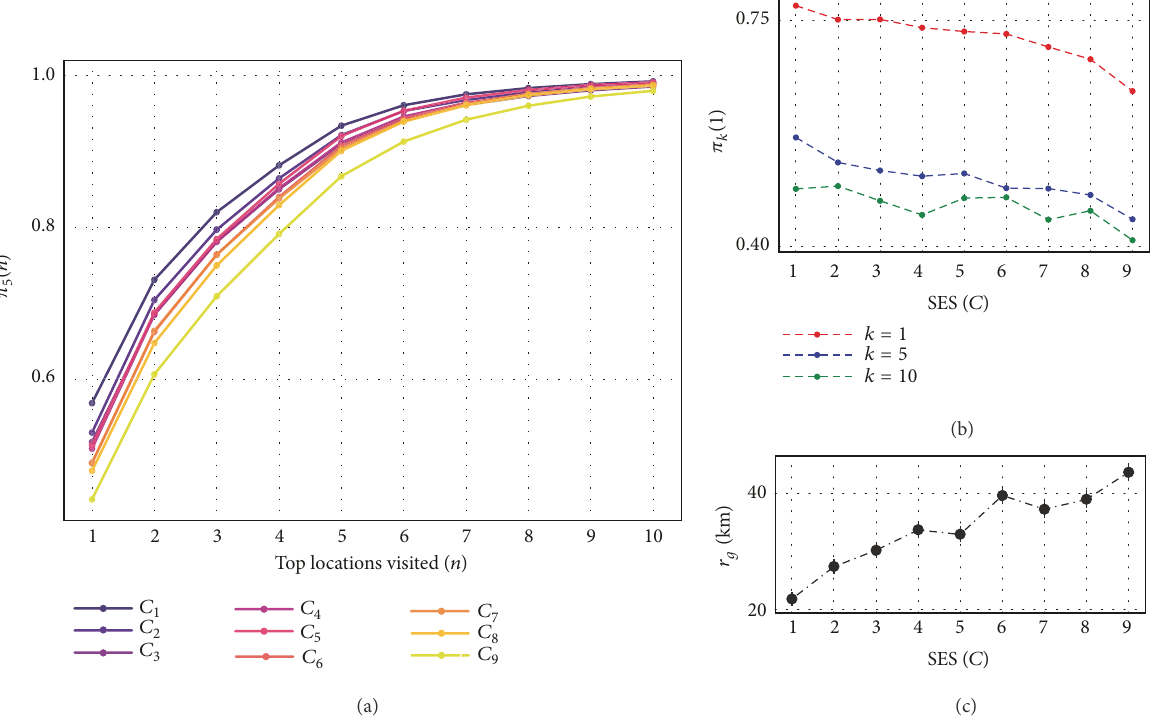
Figure 3: (a) The fraction of time a user spends in his/her top 10 most visited locations per socioeconomic class. (b) 𝜋 𝑘 (1) , fraction of time spent at the most visited location per socioeconomic class for users with at least 𝑘 different locations. (c) Average radius of gyration per socioeconomic class (error bars are computed as 𝜎(𝑟 𝑔 )/√𝑁 , with 𝑁 number of